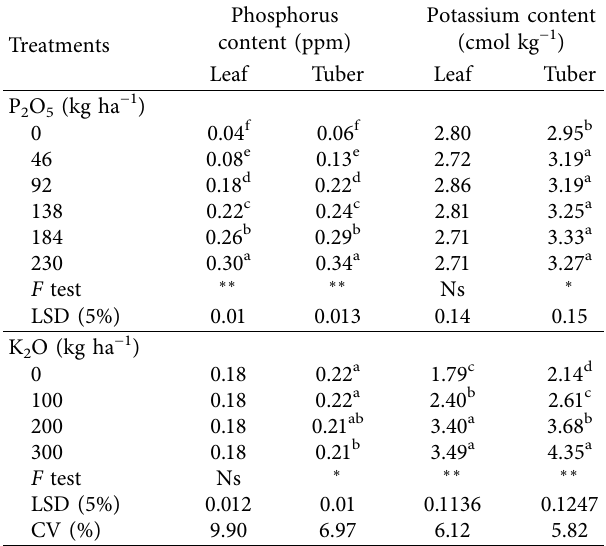
Table 5: Phosphorus and potassium concentration levels of dried potato leaves and tuber tissues.